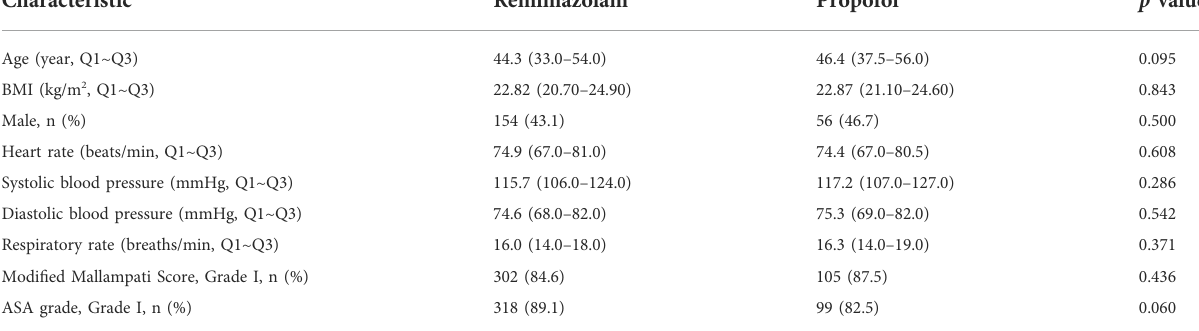
TABLE 2 Baseline characteristics of study